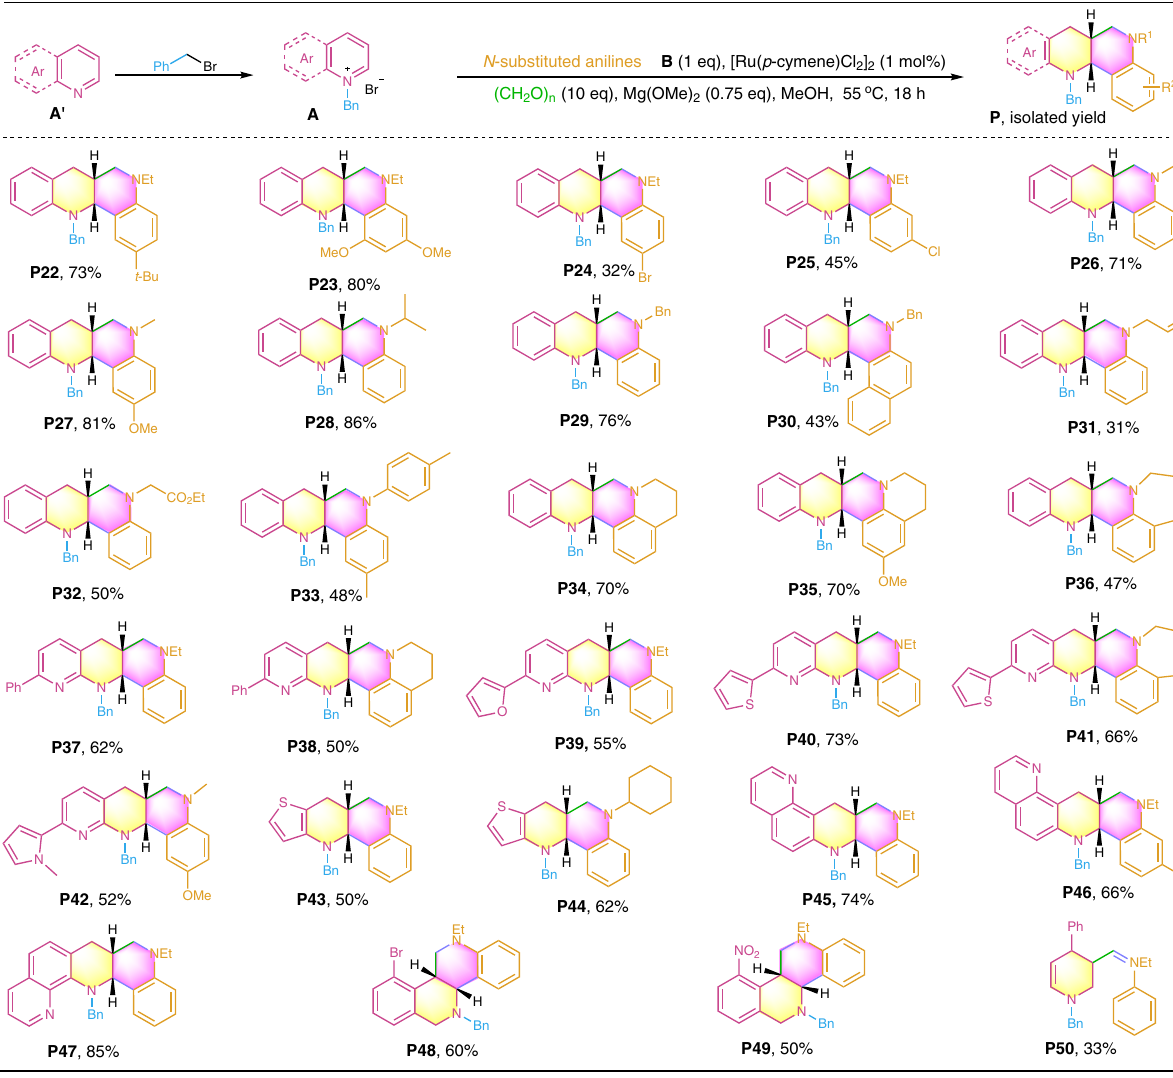
Fig. 3 Diastereoselective access to fused N-heterocycles P22 – P50 by variation of both azaarenes and anilines. Reactions were conducted on a 0.2 mmol scale under the standard conditions. Isolated yields are